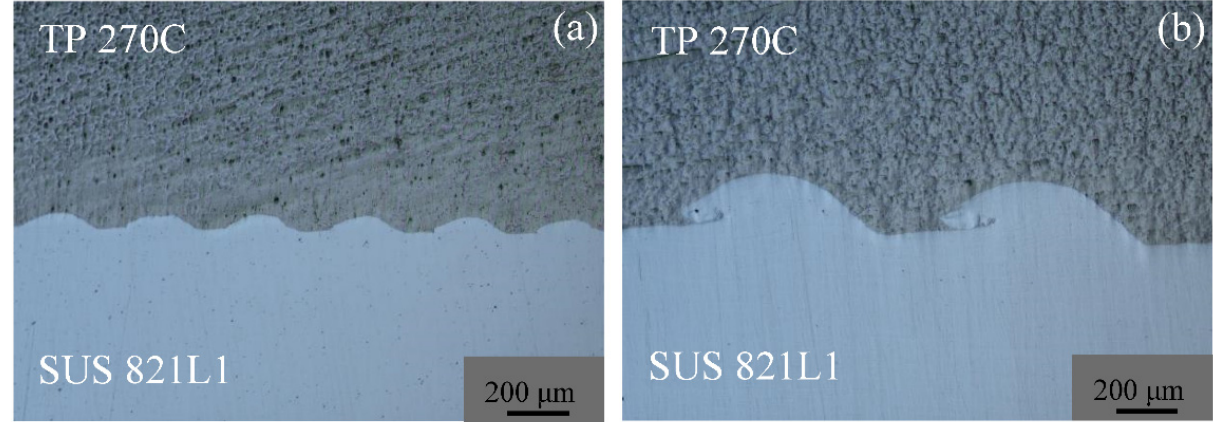
Figure 2. Welding interface: ( a ) stand-off = 5 mm; ( b ) stand-off = 15 mm.